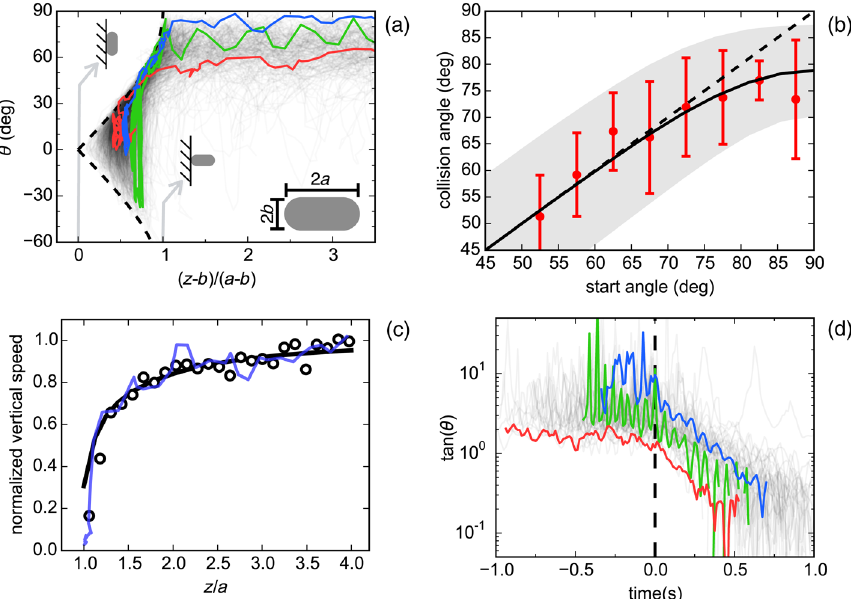
FIG. 3. (a) Gray lines plot the body pitch θ as a function of the normalized distance ð z − b Þ = ð a − b Þ . Blue, green, and red lines refer to bacteria approaching the wall with, respectively, high, intermediate, and low impact angles. The black dashed line represents the contact condition [ ð z − b Þ = ð a − b Þ ¼ j sin θ j ]. (b) Collision angle at first impact plotted versus the corresponding starting value (red dots). Error bars represent þ = − , the standard deviation over cells with a start angle falling in the same 5° bin interval. The solid black line is the theoretical prediction for cells reorienting with a purely diffusive motion ( D r ¼ 0 . 06 rad 2 = s), while the shaded area represents the corresponding standard deviation. (c) The blue line plots the vertical component of the velocity as a function of the cell-wall distance for a bacterium approaching the glass wall almost perpendicularly ( θ ≈ 90 °). The velocity has been normalized to its bulk value, while the cell-wall distance z is divided by the cell-body half-length a . The same quantity, averaged over all bacteria having an angle θ > 70 °, is shown as a blue line. The black line plots a theoretical prediction that only accounts for an increase of the cell-body drag due to the presence of the wall [see Eq. (1)]. (d) Time evolution of tan θ during reorientation. Color coding is the same as in (b). For each curve, the time origin has been shifted so that the cell first hits the wall at time t ¼ 0